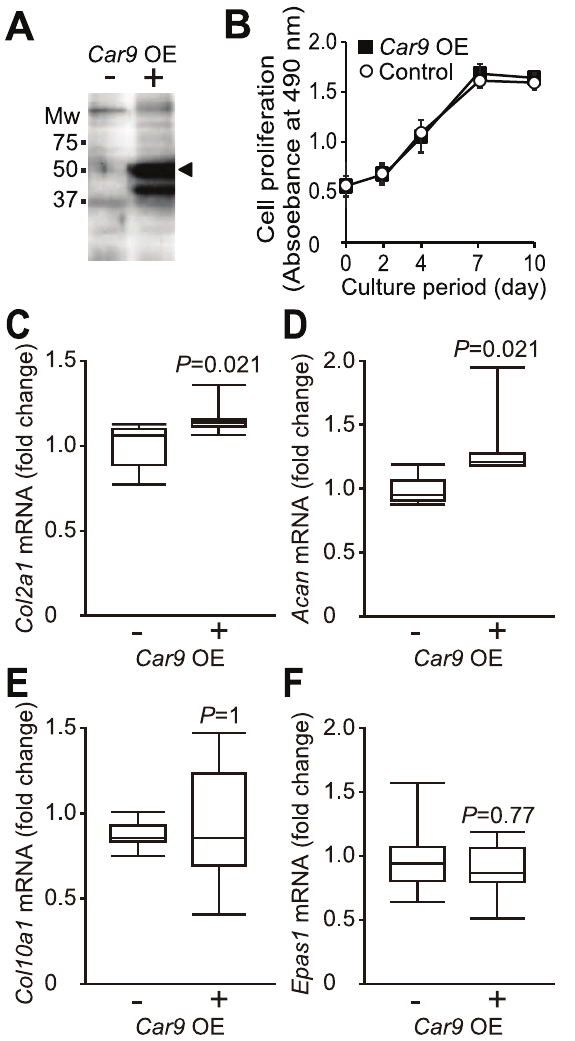
Figure 6. Effects of forced expression of CA IX on chondrocyte proliferation and mRNA expression of Col2a1 , Acan , Col10a1 , and Epas1 . Primary mouse chondrocytes were transfected with a CA IX-expression plasmid ( + ) or its control plasmid (-). A. At 48 hours after transfection, the expression of CA IX (58kDa) was assessed by western blot analysis using anti-mouse CA IX antibody. CA IX band is indicated by an arrowhead. B. Proliferation of chondrocytes introduced with CA IX-expression (filled square) and control (unfilled circle) plasmids was assessed spectrophotometrically using CellTiter 96 H Aqueous One Solution. Data are expressed as the mean 6 SD (n=4). At each time point, Mann-Whitney U -test with Bonferroni correction was performed to evaluate the difference between control plasmid- and CAIX- expression plasmid-transfected cells. No significant difference between the values was indicated at any time point ( a =0.01). C-F. The expressions of Col2a1 (C), Acan (D), Col10a1 (E), and Epas1 (F) were quantitatively analyzed by real-time RT-PCR, with the expression level of each normalized to that of Gapdh . Data are expressed by boxplots (n=6) for fold changes caused by introduction of Car9 siRNA (the sample maximum, the upper quartile, the median, the lower quartile, and the minimum observation). P -values determined by two-tailed Mann-Whitney U -test are indicated. doi:10.1371/journal.pone.0056984.g006 differentiation of chondrocytes and endochondral ossification